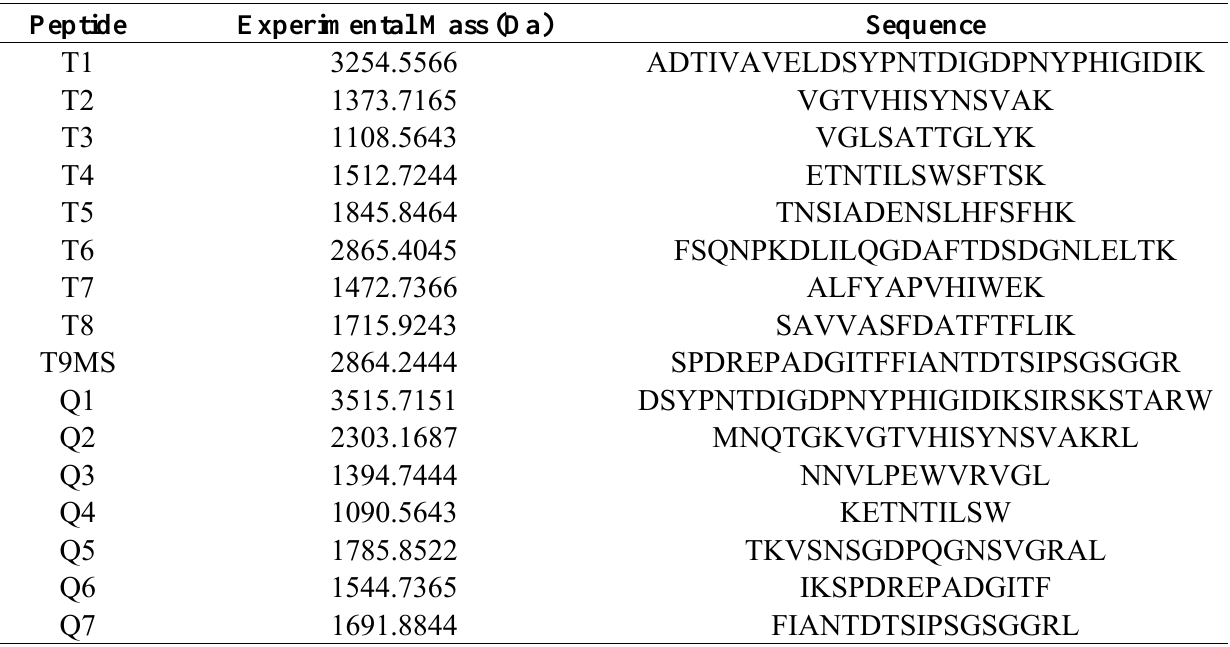
Table 2. Sequenced peptides of D. wilsonii lectin (DwL) and their respective molecular